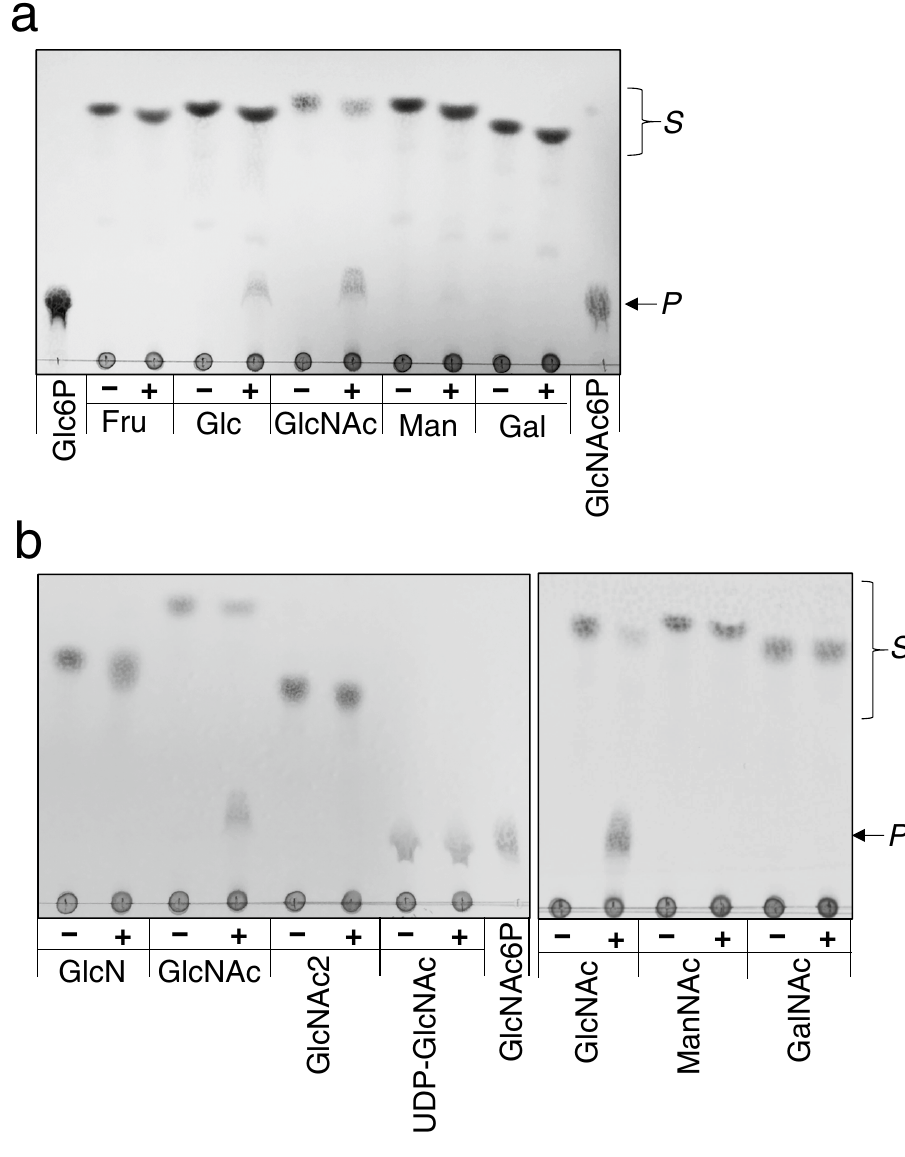
Figure 2. TLC analyses of sugar substrate specificity of YLR446Wp. The substrate specificity of the enzyme for monosaccharides ( a ) and amino sugars ( b ) was monitored by TLC. A reaction containing ATP, MgCl 2 , and each of the following sugars: GlcNAc, Glc, fructose (Fru), mannose (Man), galactose (Gal), glucosamine (GlcN), N’N’ -diacetylchitobiose (GlcNAc2), UDP-GlcNAc, N -acetylmannosamine (ManNAc), or N -acetylgalactosamine (GalNAc) was carried out for 30 min with (+) or without (−) enzyme. Glc-6-P or GlcNAc-6-P (15 nmol each) was applied to the TLC plate as the standard compound. S , sugar substrates; P ,